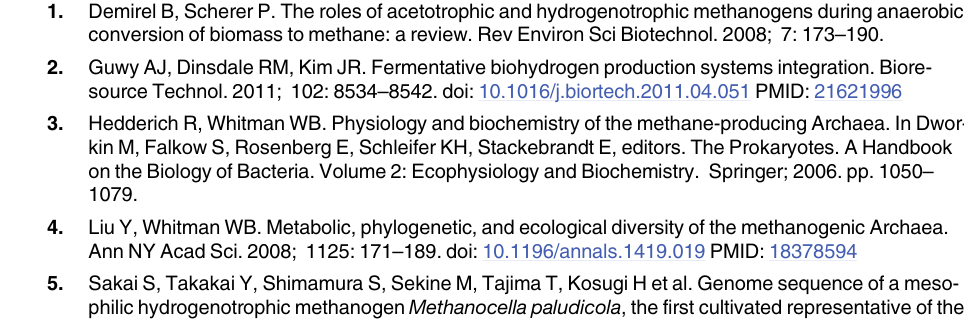
S1 Fig. Significant pathway modules (pink) in the methane metabolism map from the KEGG database. S1 Table. Number of reads assigned to respective taxonomic branches by MEGAN5. S2 Table. Abundance analysis of KEGG modules, classes and KEGG orthology groups ob- tained using HUMANn on the basis of sequence similarity to 28 genomes selected from the KEGG database. In addition, KO groups were mapped to EC numbers for selected enzymes putatively involved in methane metabolism (including intermediate and substrate